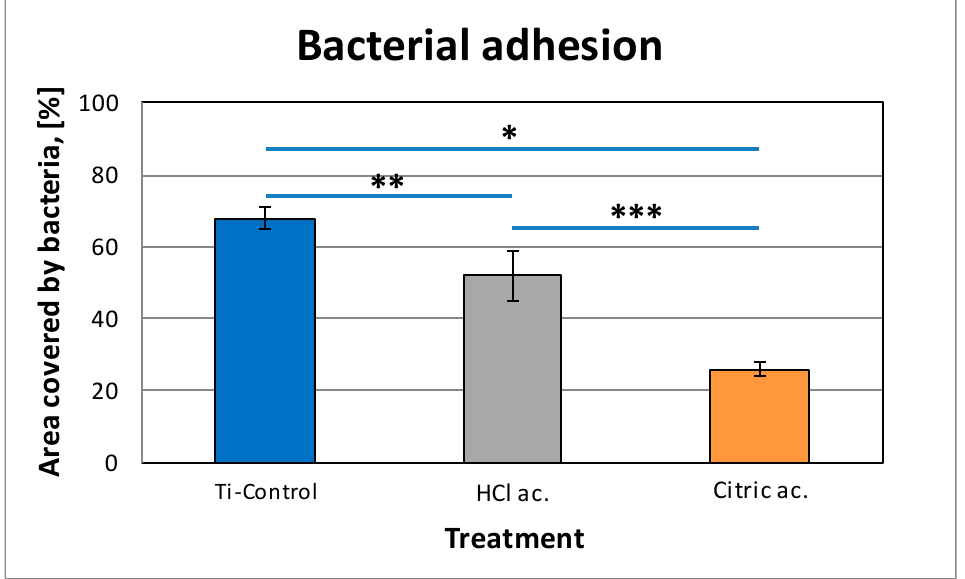
Ti-Control HCl ac. Citric Figure 6. Live/dead staining of S. S. sanguinis on control and passivated samples (HCl, citric acid). Symbols ( ∗ , ∗∗ , ∗∗∗ ) indicate statistical differences between conditions with p < 0.05. The ratio of bacteria attached to the surface (Table 4) confirmed a significant decrease with HCl passivated samples compared to Ti (only 34.54% of adhesion). For the citric